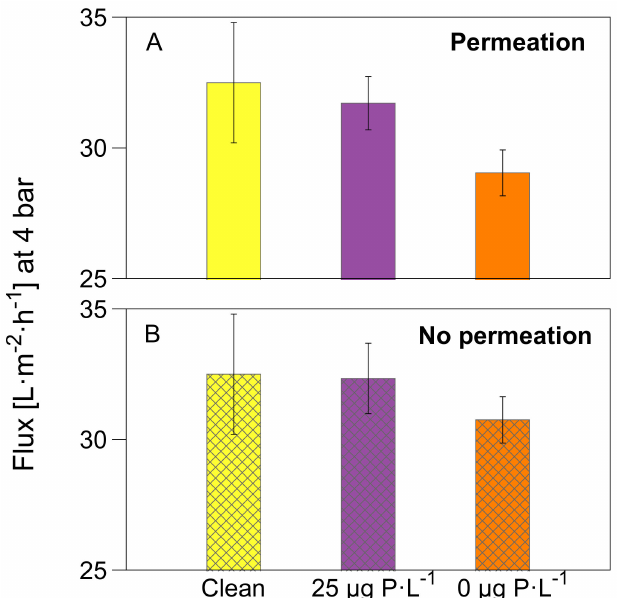
Figure 4. Flux at 4 bar of transmembrane pressure for the MFSs run under ( A ) permeation conditions at a constant flux of 15.6 L · m 2 · h − 1 , and ( B ) without permeation with varying dosed phosphorus con- centrations (0 and 25 µ g P · L − 1 ) and a dosed assimilable organic carbon concentration of 250 µ g C · L − 1 in the feed water. The transmembrane pressure was varied at the end of the experiment after 4.7 days of nutrient dosage. The error bars represent the data of independent triplicate MFS